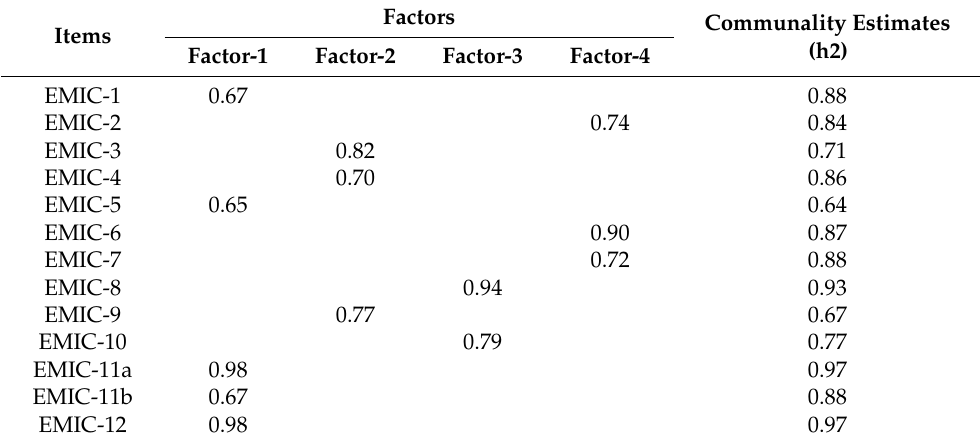
Table 3. Extracted factors from the Arabic version of the